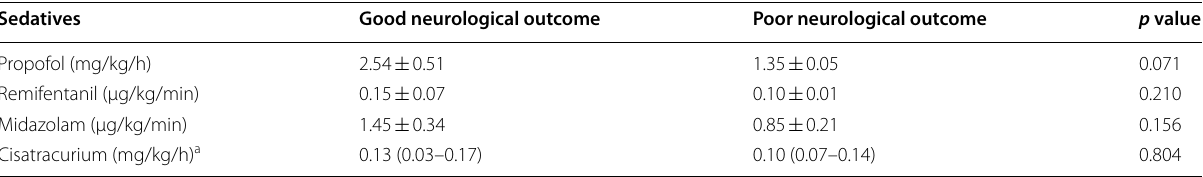
Data are presented as mean SD and median with interquartile ranges ± a Cisatracurium was administered in 20 and 24 patients with a good and poor neurological outcome, respectively